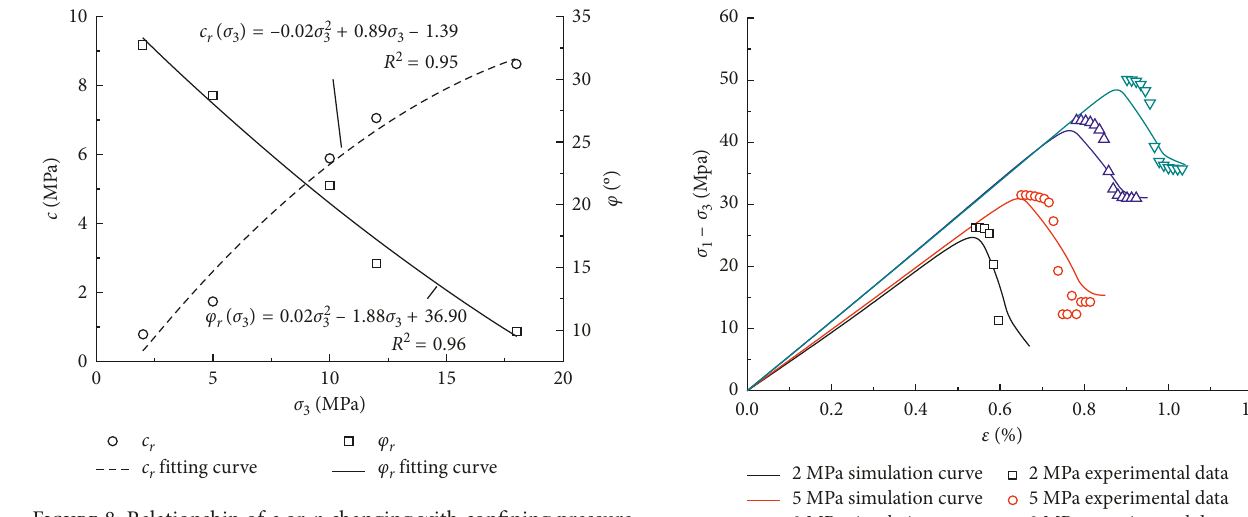
Figure 8: Relationship of c or φ changing with confining pressure at the starting point of the residual stage.